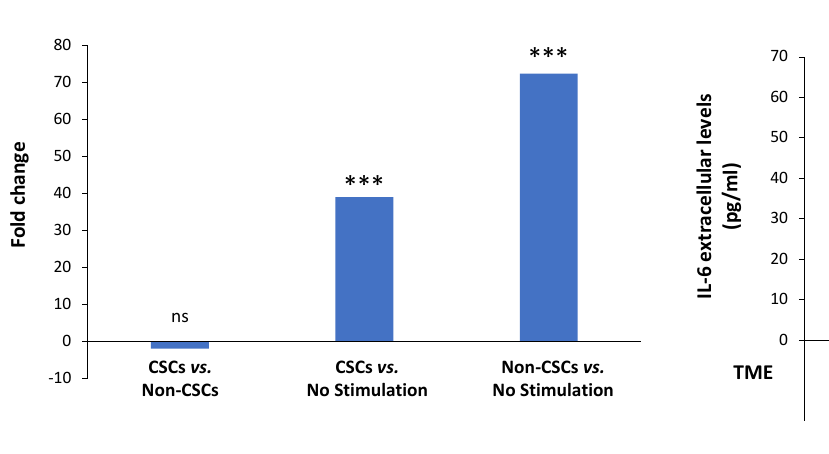
A2. IL-6: ProteinA1. IL-6: mRNA